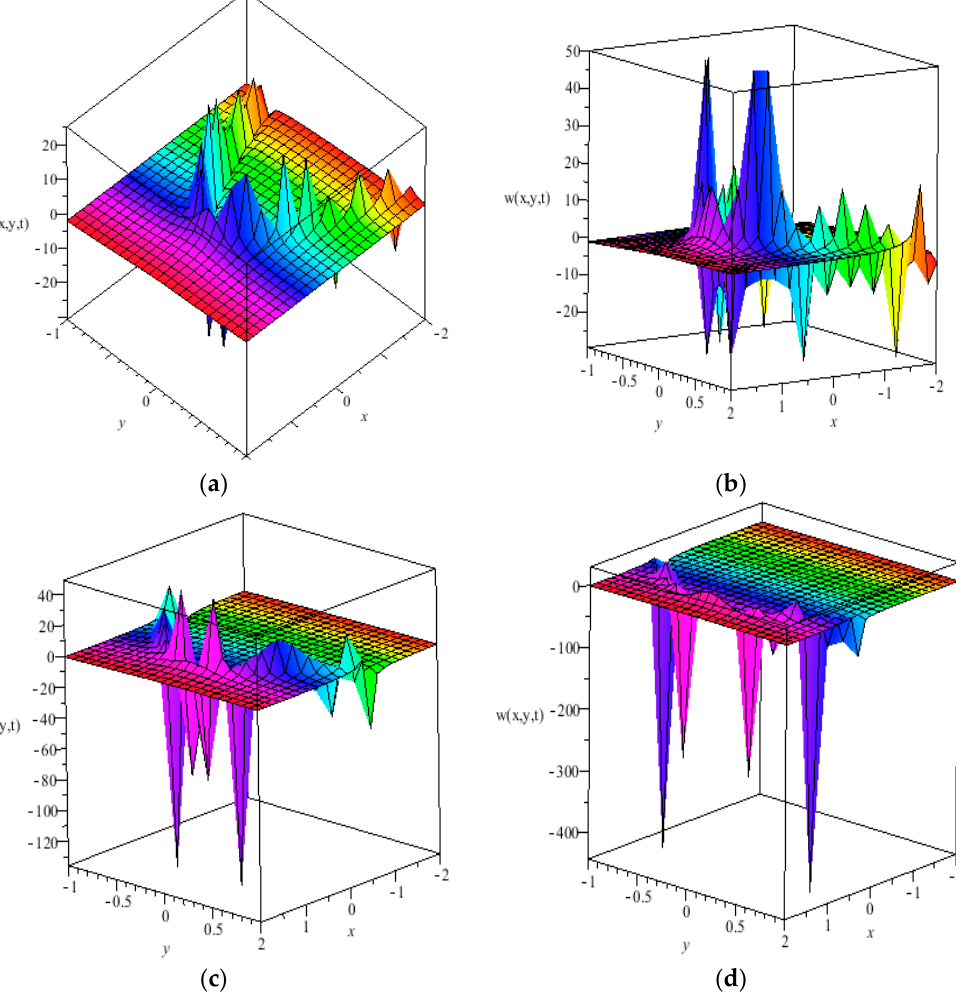
Figure 1. ( a ) w ( x, y, t ) at c = 1, t = 0.3 s; ( b ) w ( x, y, t ) at c = 1, t = 0.5 s; ( c ) w ( x, y, t ) at c = 1, t = 0.8 s; ( d ) w ( x, y, t ) at c = 1, t = 1.2 s.